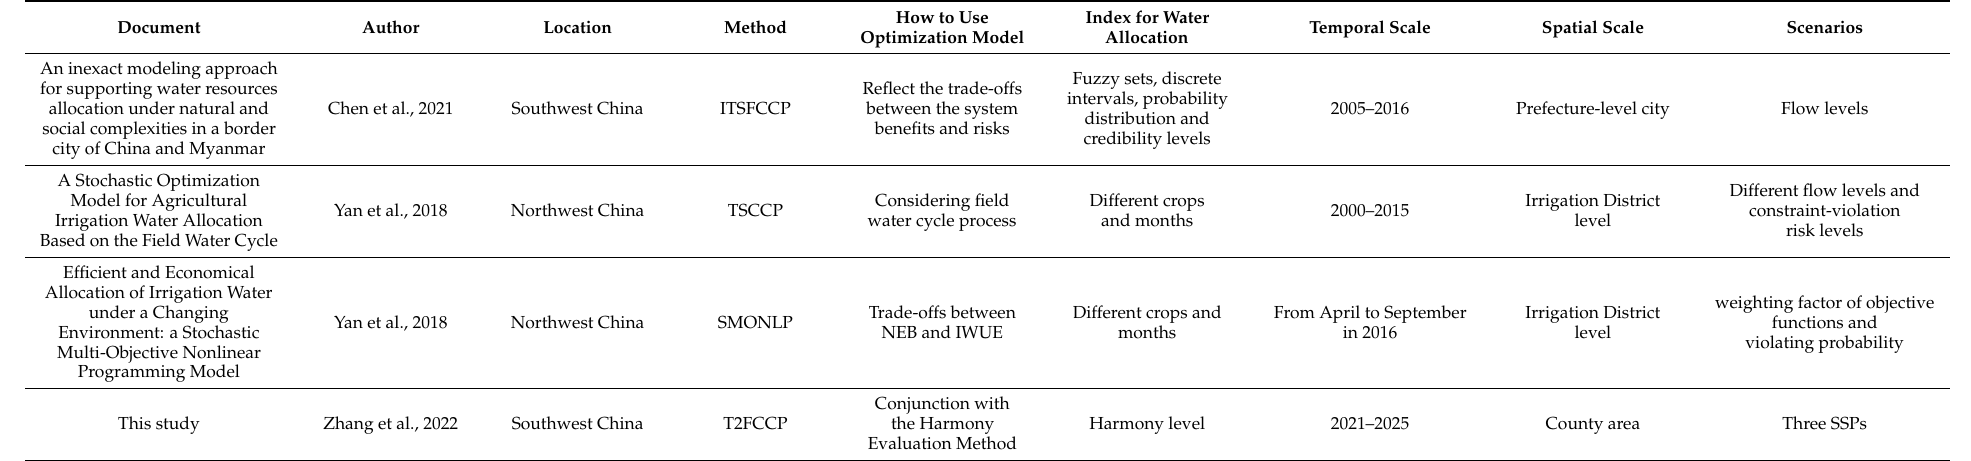
Table 1. Summary of research on regional water resources optimal